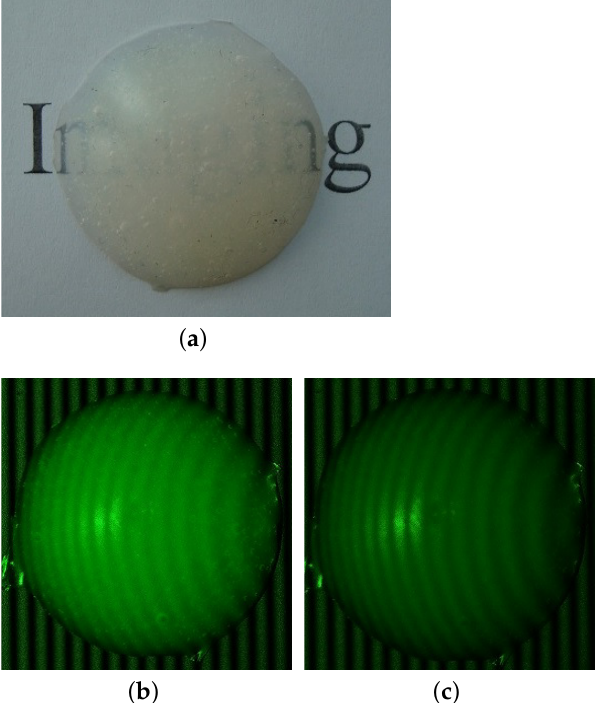
Figure 3. The measuring result of using polarization technique: ( a ) photo of the original target; ( b ) image without polarizer; and ( c ) image with